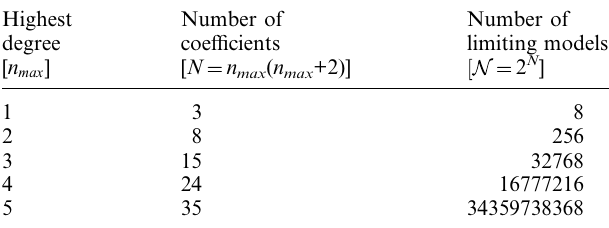
Table 1. The number of limiting geomagnetic-field